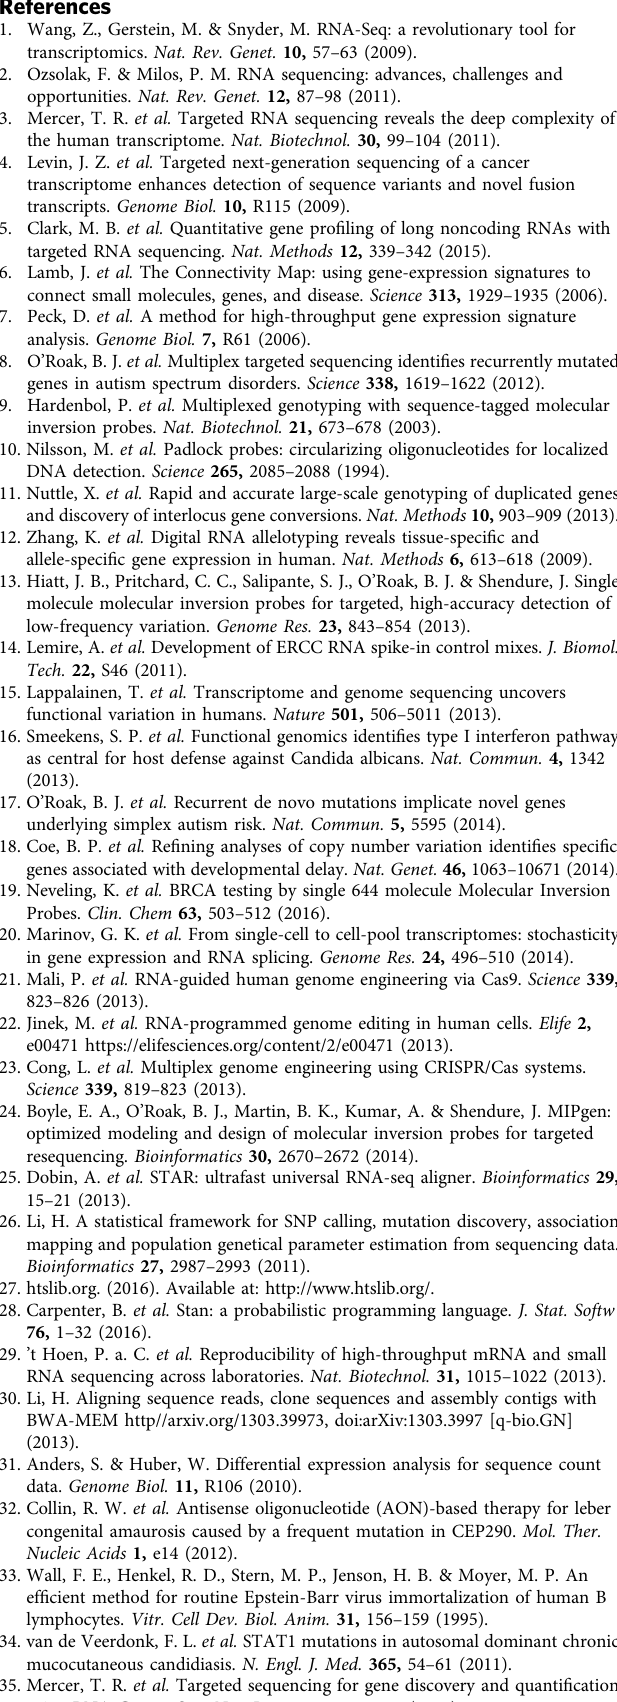
exonuclease program (Supplementary Table 13) included the following steps: (1) 37 (cid:2) C for 45min and (2) 95 (cid:2) C for 2min and (3) samples were cooled down to 4 (cid:2)